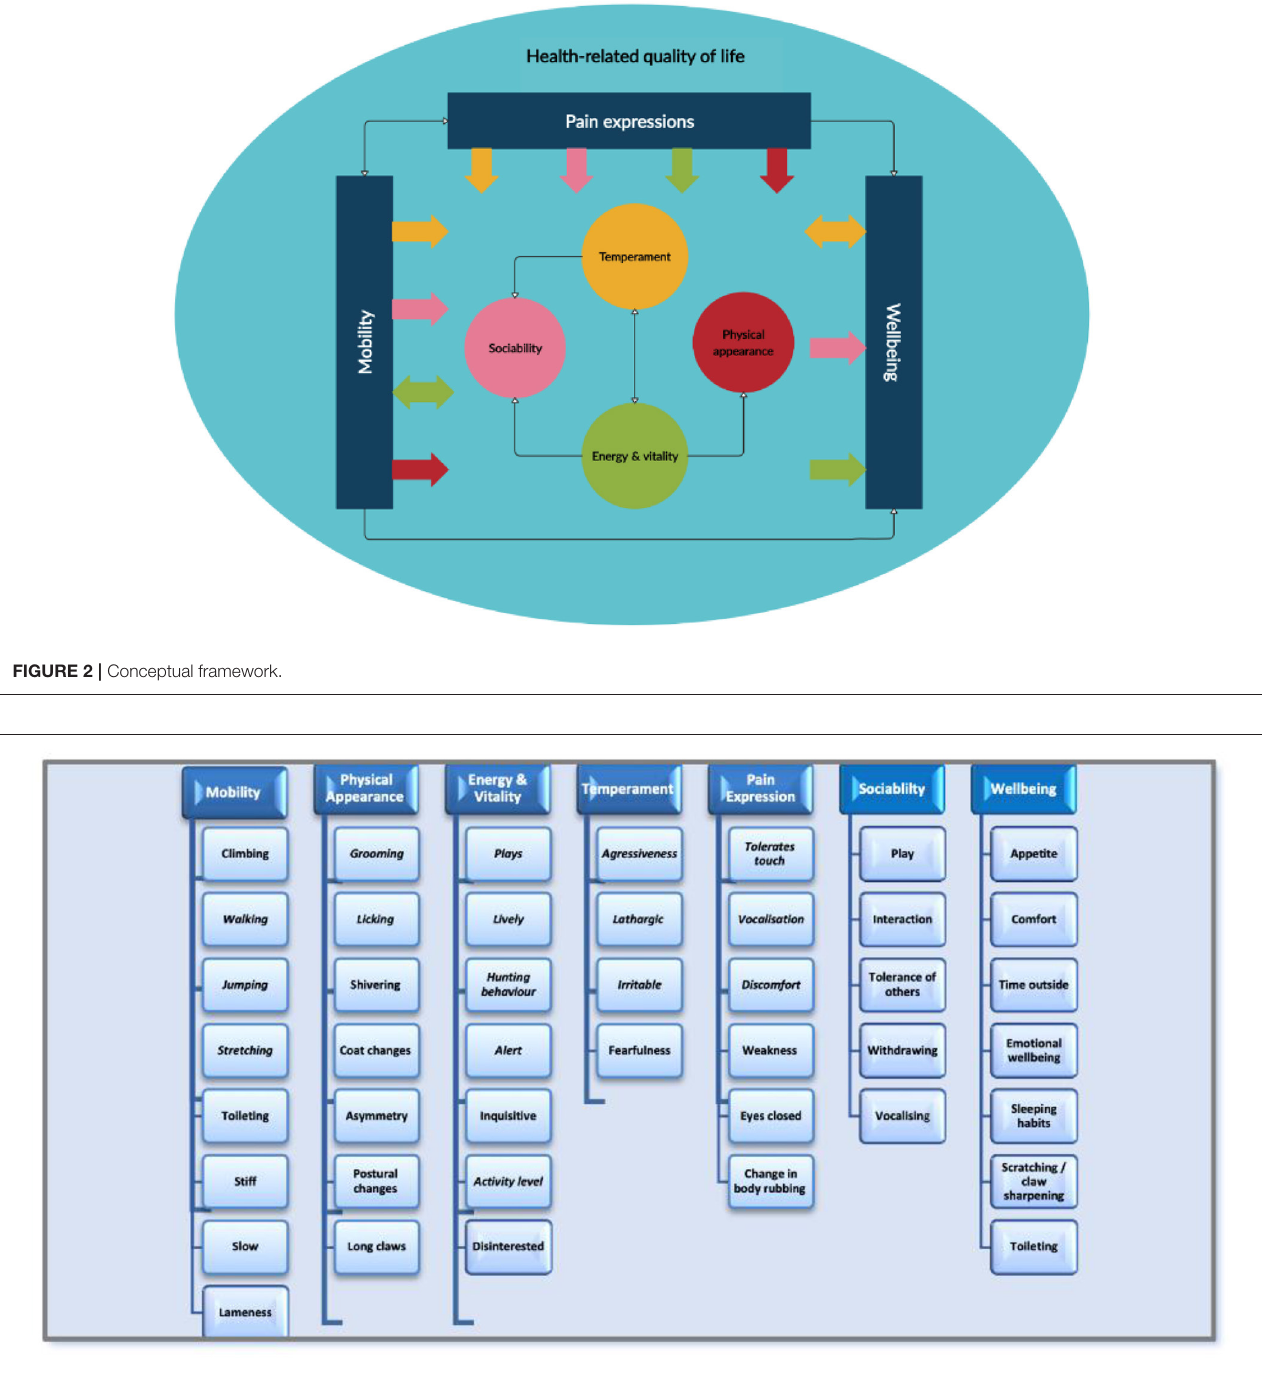
FIGURE 3 | Quality-of-life